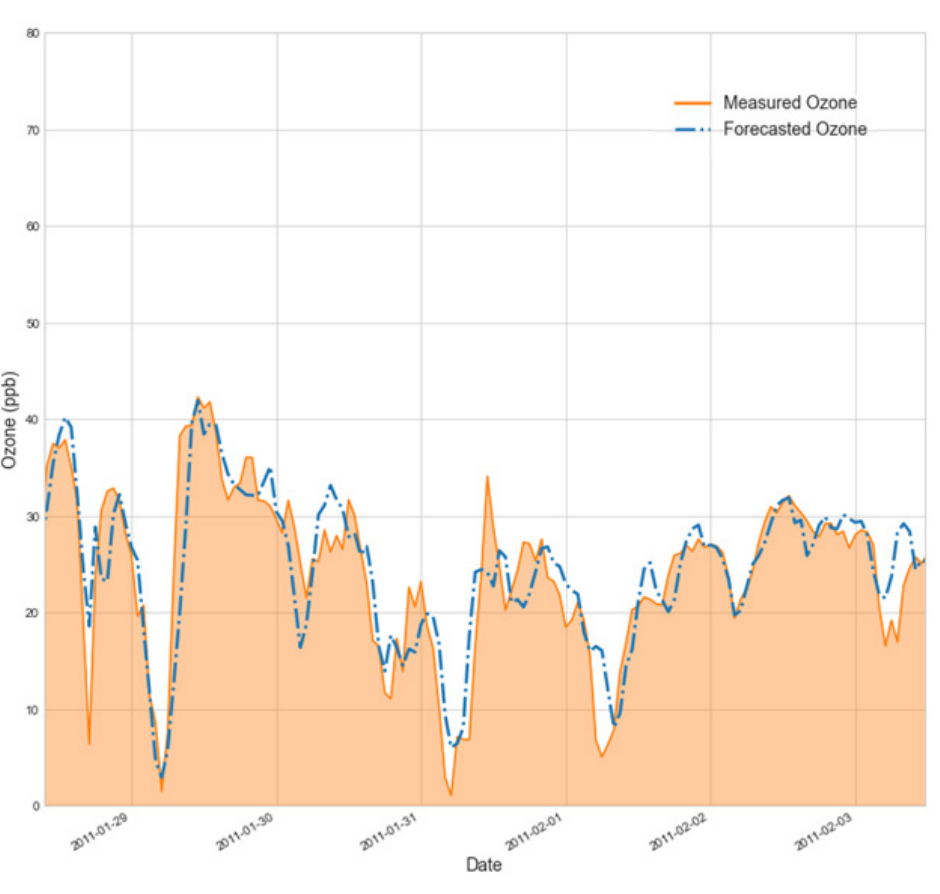
Figure 10. Comparison between forecasted ozone values using GraphSAGE for the validation dataset and actual measured concentrations for 3 h forecasting horizon.